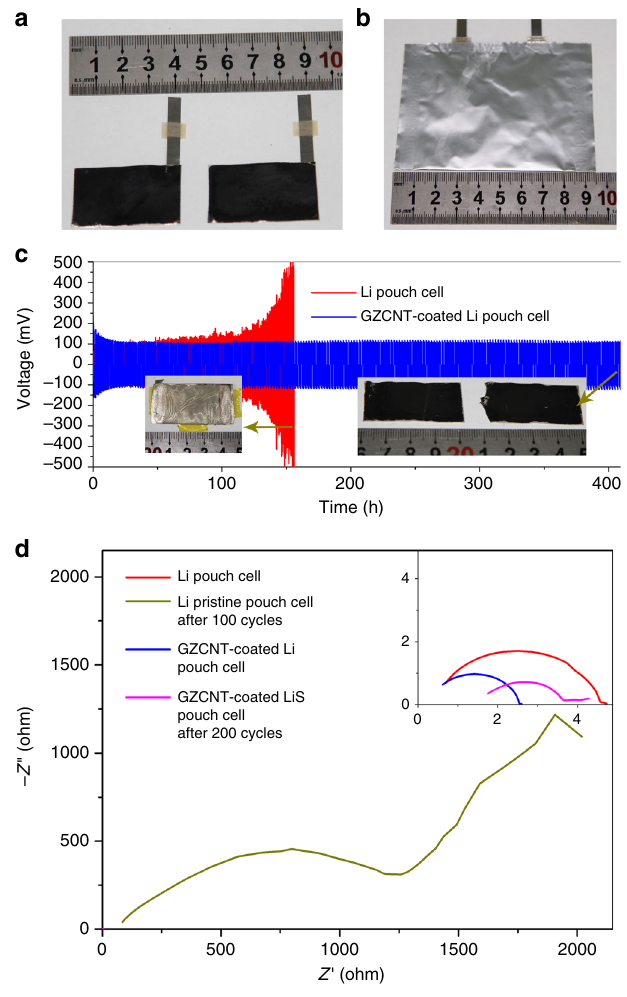
Fig. 8 Electrochemical performance of 10 cm 2 pouch cells assembled by Li foils with GZCNT interfacial layers. a Digital photos of two 40 × 25 mm 2 GZCNT-coated Li foils and b the pouch cell assembled by them. c Comparison of the cycling performance of symmetric pouch cells assembled by blank Li foils (red), and Li foils with GZCNT (blue) at a charge/discharge current density of 1 mA cm – 2 (10 mA in total) with a stripping/plating capacity of 1 mAh cm – 2 (10 mAh in total) for 210 cycles. The insets are digital photographs of Li foil (left) and GZCNT-coated Li foils (right) in pouch cells after 100 and 200 cycles, respectively. bare Li foils and GZCNT-coated Li foils and after 100 and 200